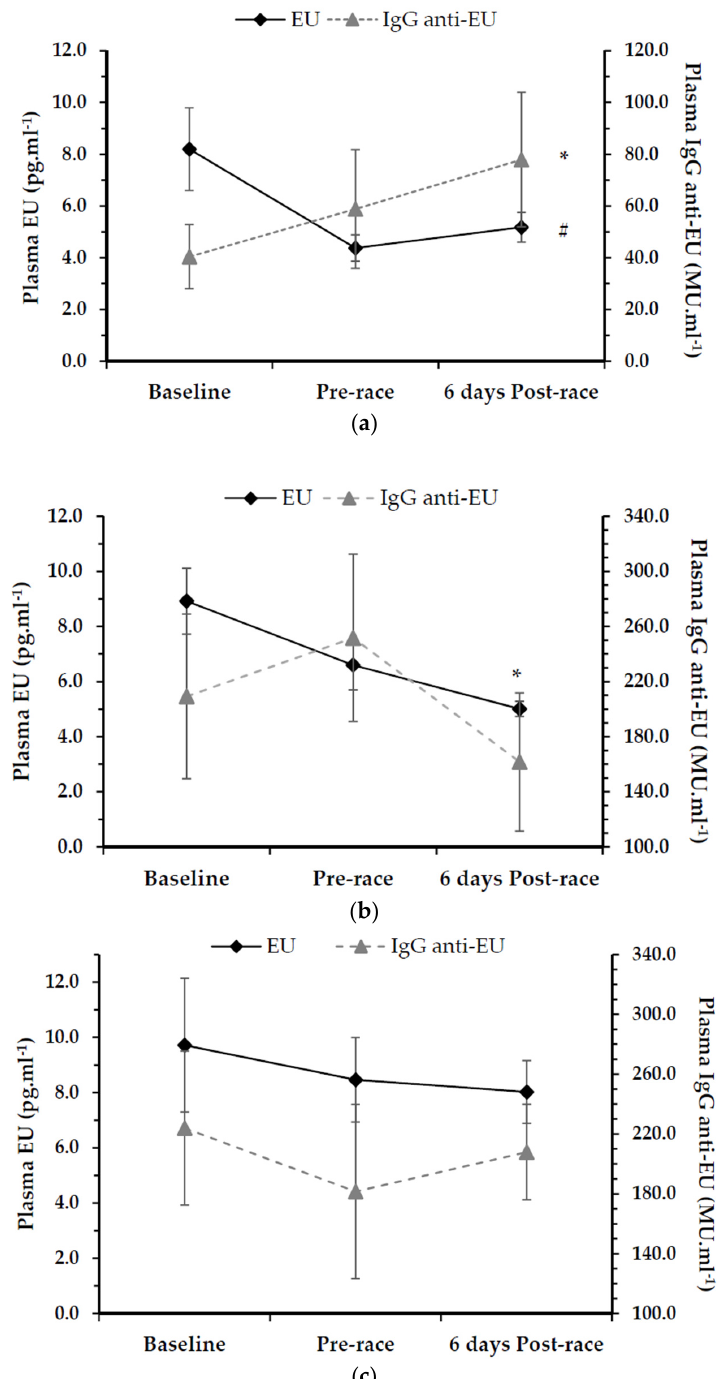
Figure 1. ( a ) Plasma endotoxin unit (EU) concentrations (pg ∙ mL − 1 ) and IgG endotoxin antibodies (anti ‐ EU; MU ∙ mL − 1 ) for LAB 4ANTI group (Mean ± SE). * denotes lower IgG anti ‐ EU values overall than both LAB 4 and PL conditions ( p < 0.001). # denotes significant reduction in endotoxin units over time within group ( p = 0.03); ( b ) Plasma endotoxin unit (EU) concentrations (pg ∙ mL − 1 ) and IgG endotoxin antibodies (anti ‐ EU; MU ∙ mL − 1 ) for LAB 4 group (Mean ± SE). * denotes significant difference from baseline for endotoxin units within group ( p = 0.047); ( c ) Plasma endotoxin unit (EU) concentrations (pg ∙ mL − 1 ) and IgG endotoxin antibodies (anti ‐ LPS; MU ∙ mL − 1 ) for PL group (Mean ± SE). No significant differences reported ( p > 0.05).